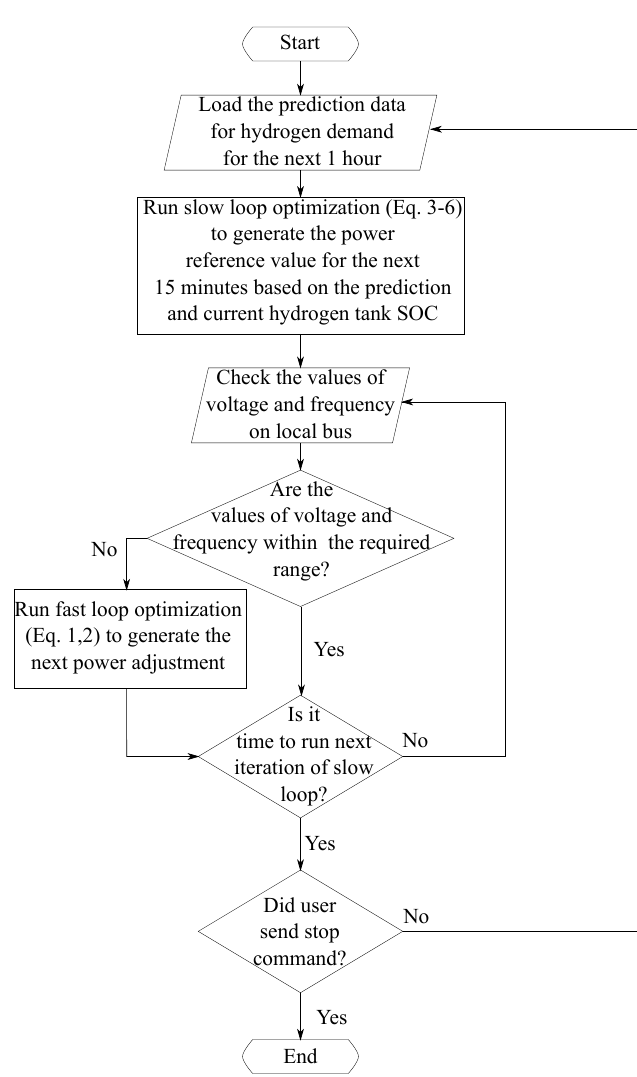
Figure 4. Flowchart depicting the operation of the front end controller (FEC) with an